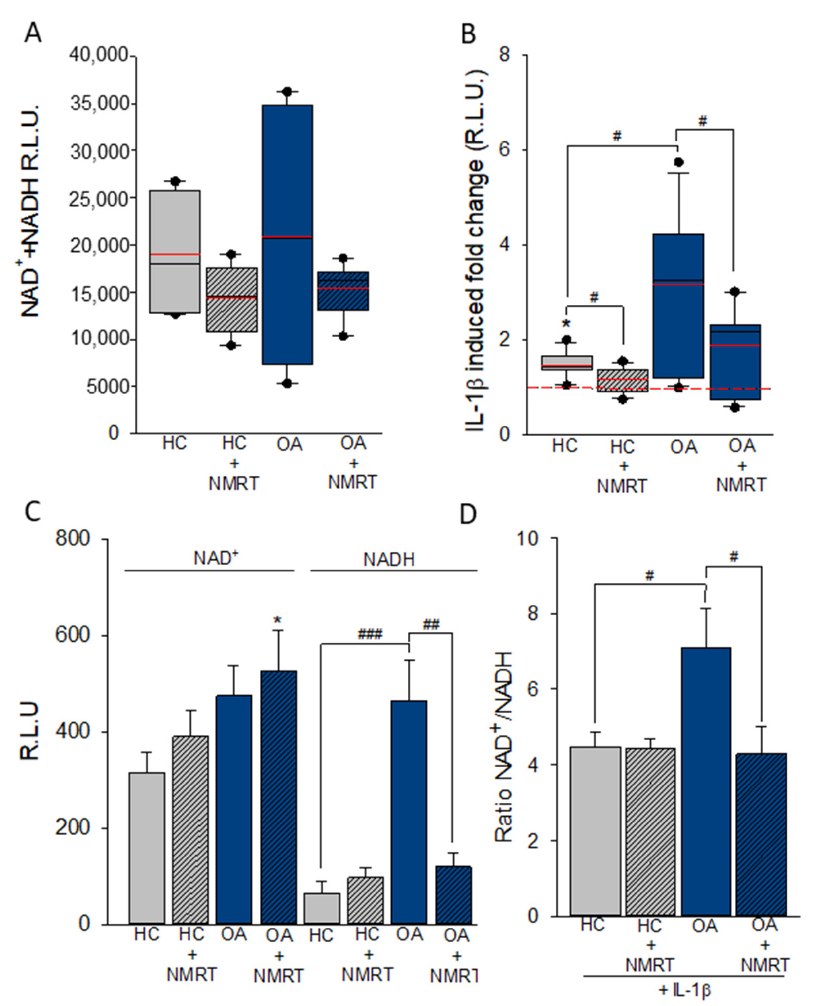
Figure 3. NAD (+) and NADH induced luminescence in HC and OA cells with and without NMR treatment. Box plots with the 5th/95th percentile for HC and OA cells ± NMRT ( n = 6) ( A ) and the IL-1 β induced change under these conditions ( B ) are given. The significant effect by IL-1b in HC cells is indicated by *; # depicts the significant difference between IL-1 β effect in HC and OA as well as OA and OA NMRT treated cells. The statistical significances for ( A , B ) were evaluated by using the Mann–Whitney Rank Sum Test; the red lines comply with the mean values. NAD (+) and NADH individual measurements are shown ( C ) as well as the NAD (+) /NADH ratio in the presence of IL-1 β and NMR treatment is being demonstrated ( D ) ( n = 3). * is the level of significance for NMRT on HC cells, #: significant difference between IL-1 β effect in HC and OA as well as OA and OA NMRT treated measured by the two tailed Student’s t -test; *,#: p <0.05; ##: p <0.01; ###: p <0.001.